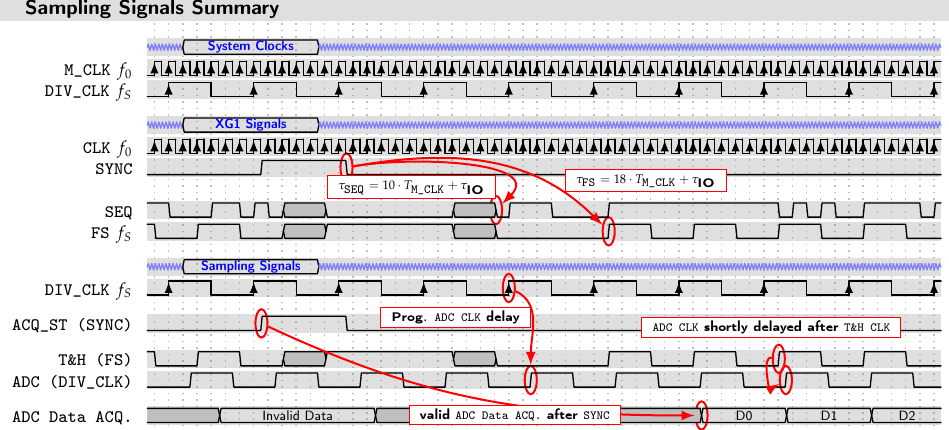
Figure 10. Signal chart summarizing system clock domains, synchronization, and timing of different layers of sampling. Note that, due to illustration reasons, M_CLK is not shown at the correct scale. One cycle of DIV_CLK actually covers 512 cycles of M_CLK ( T S = 512 · T 0